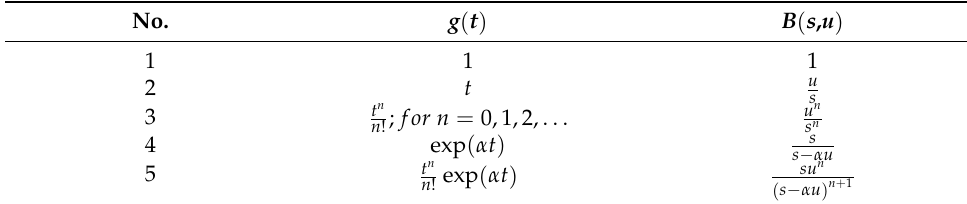
Table A1. Formable transform of some special